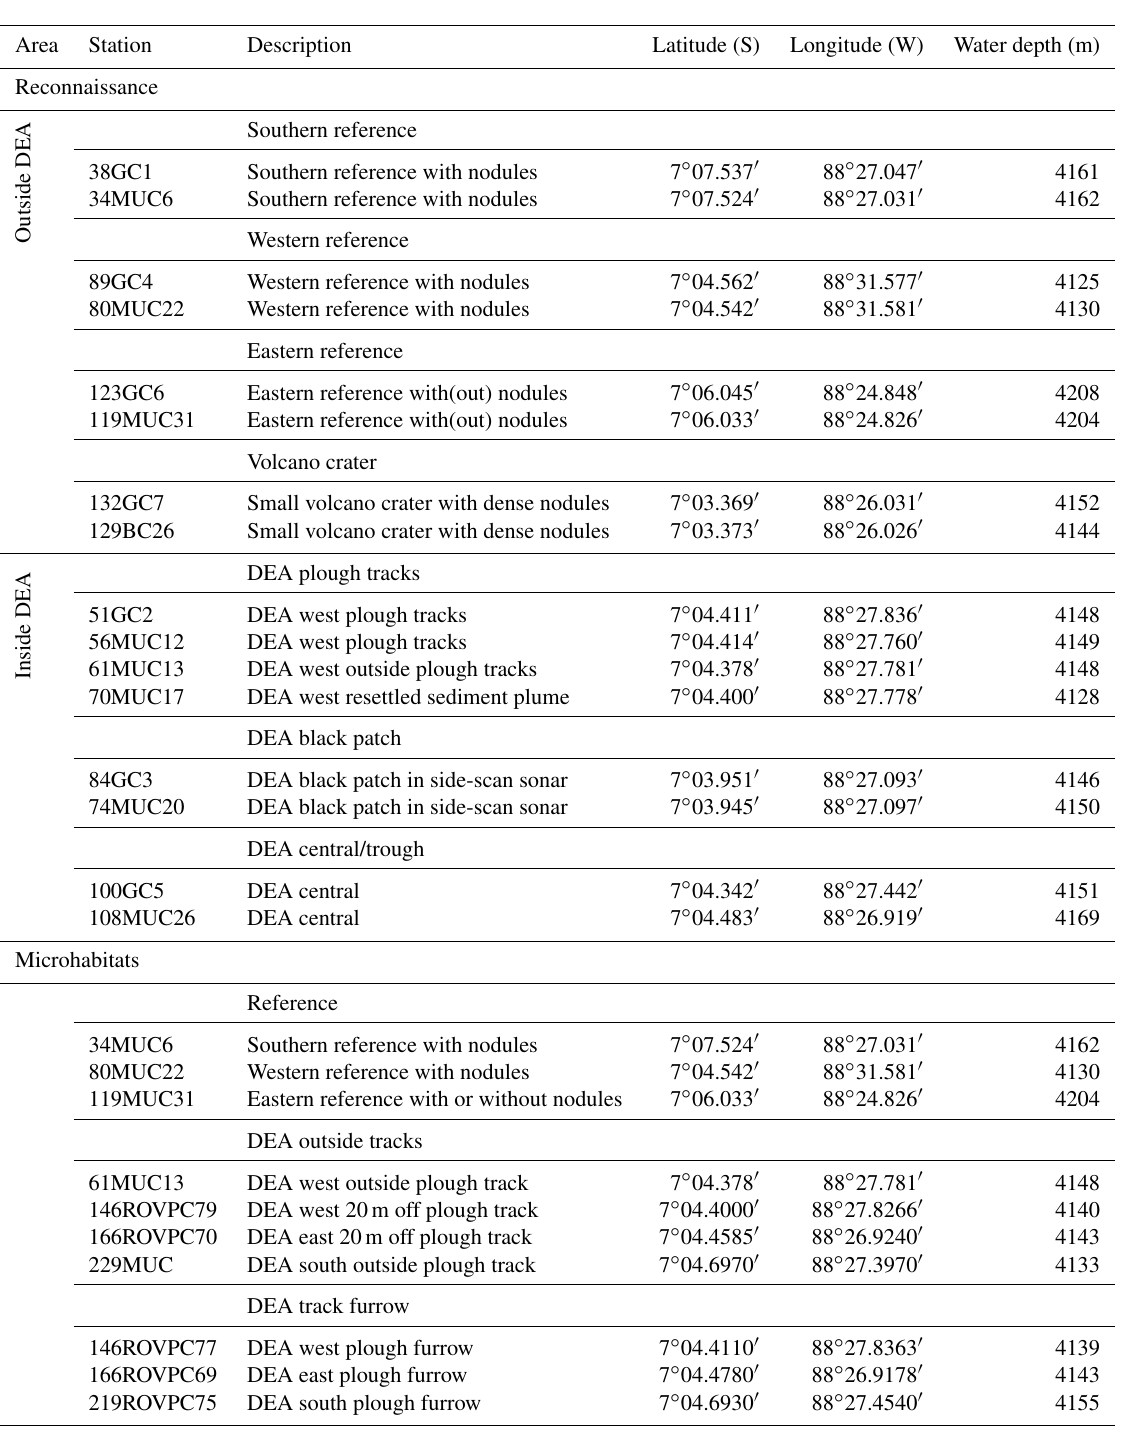
Table 1. Sampling station locations and